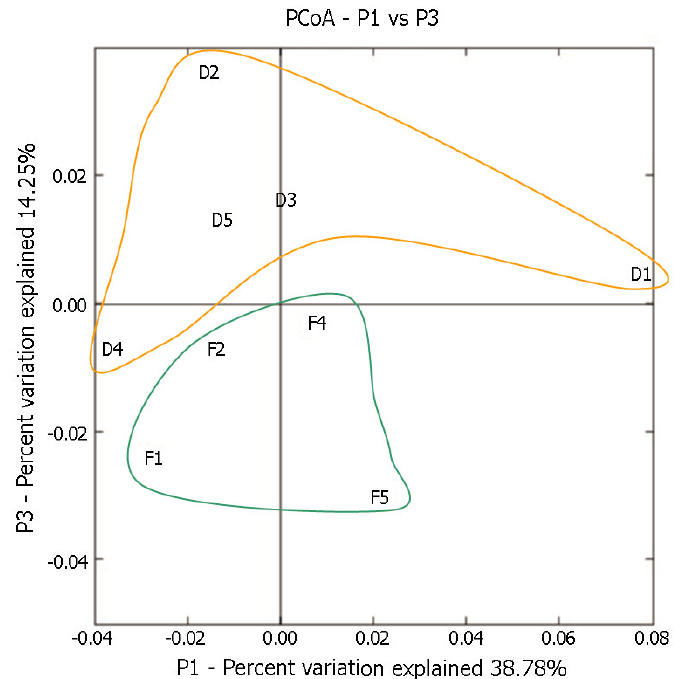
Figure S3. Principal coordinates analysis (PCoA): depicting the fecal bacterial communities of five domestic (D) and four feral (F) goats using weighted UniFrac distances. Each point corresponds to a community coded according to the goat group. The percentage of variation explained by the plotted principal coordinates is indicated on the axes. Emphasis of domestic and feral goat-associated community clustering indicated by the lines around each group.